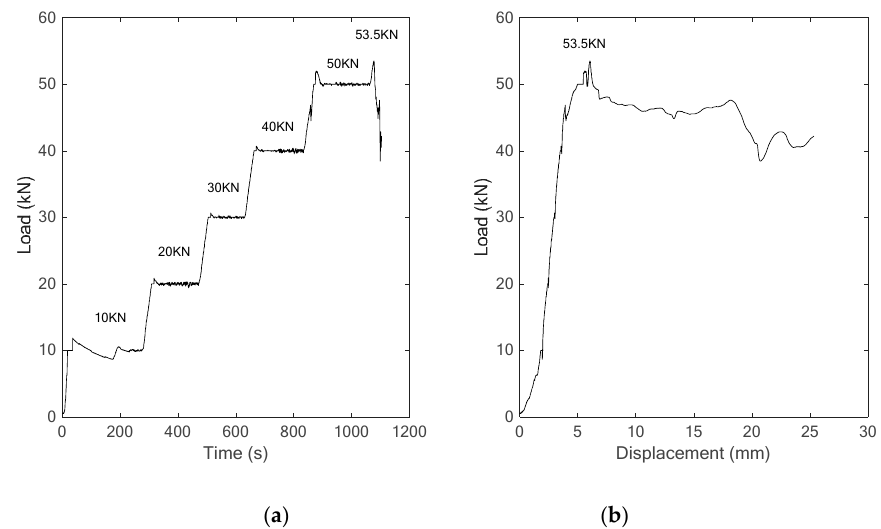
Figure 6. The curves of ( a ) time vs. load, ( b ) displacement vs. load.